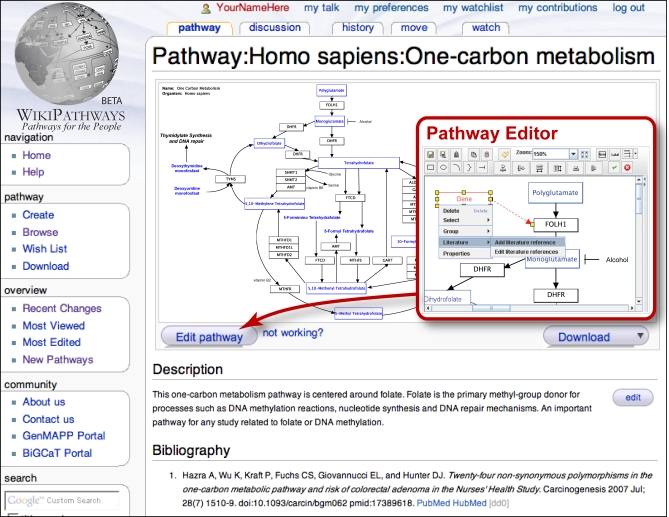
Sample WikiPathways PageEach pathway has a dedicated page for viewing and editing content. The pathway diagram is edited with an embedded applet version of PathVisio (inset). The Description and Bibliography sections can be edited in-page as well through applets that facilitate entry. Additional information about the pathway components and version history continue on the page (not shown).